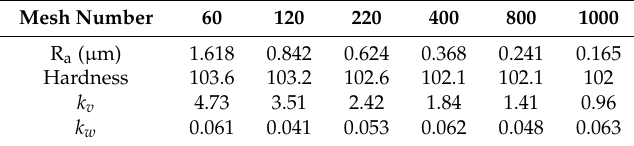
Table 1. Properties of six sandpaper ground aluminum samples.